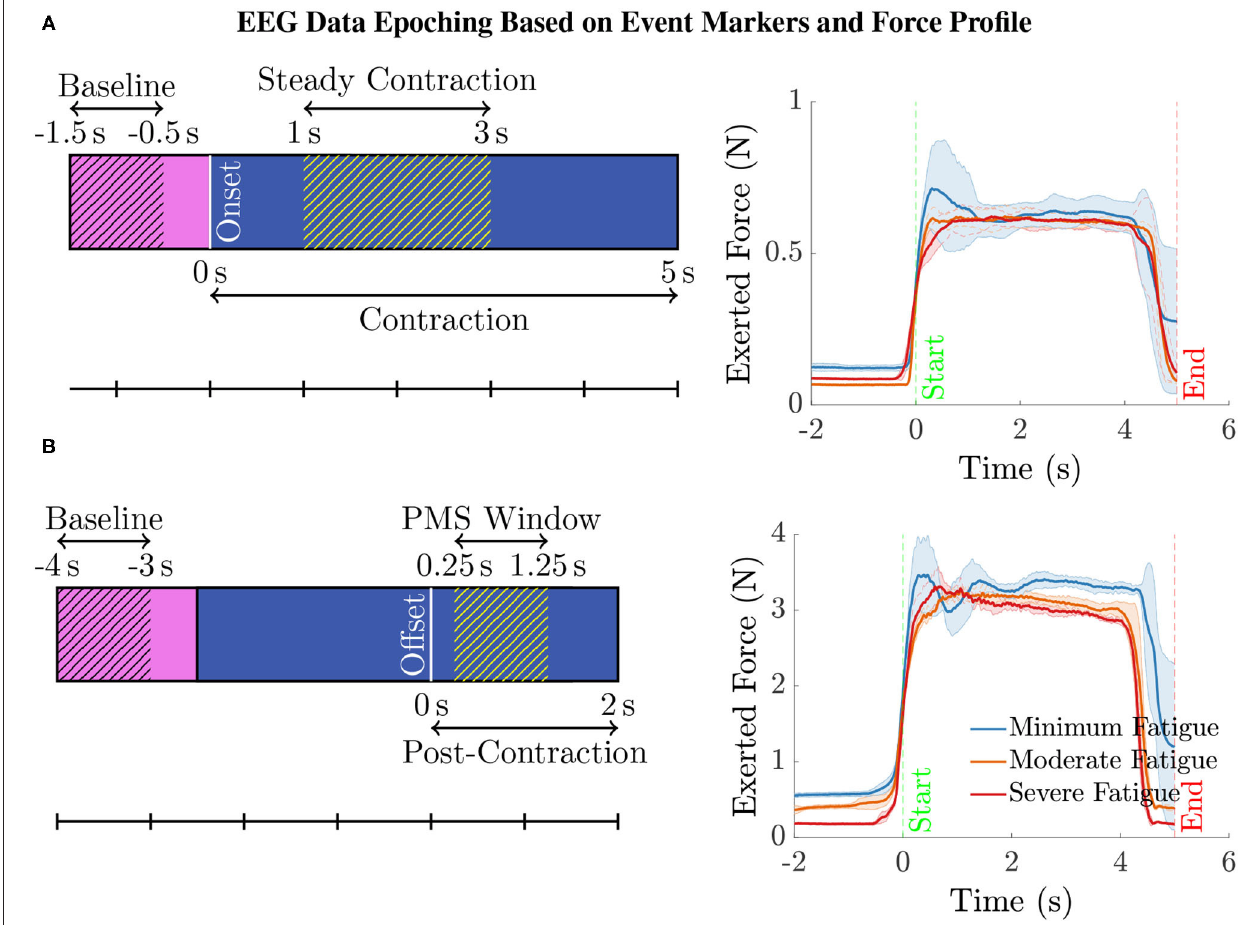
FIGURE 2 | (A) To compute the ERSP for the steady contraction during 1–3 s, EEG epochs were generated within the interval –1.5 to 5 s, where 0s represents the time instant of task initiation. The baseline EEG acquired during the period –1.5 to –0.5 s was only used for the ERSP computation to preclude the data associated with movement anticipation. Similarly, the data within the interval 0–1 s was disregarded as the subjects were ramping up to attain the target force of 40% MVC. (B) To study the ERSP for the time window of post-movement synchronization (PMS), i.e., 0.25–1.25 s with 0s denoting the time of task cessation, the data within the range –4 to 2 s was epoched. Note that the data within the interval –4 to –2.5 s was replaced by the respective baseline data in every epoch. Yet, the baseline data within the time span of –4 to –3 s was only considered for calculating the ERSP for the aforementioned reason. The data recorded during the period 0–0.25 s